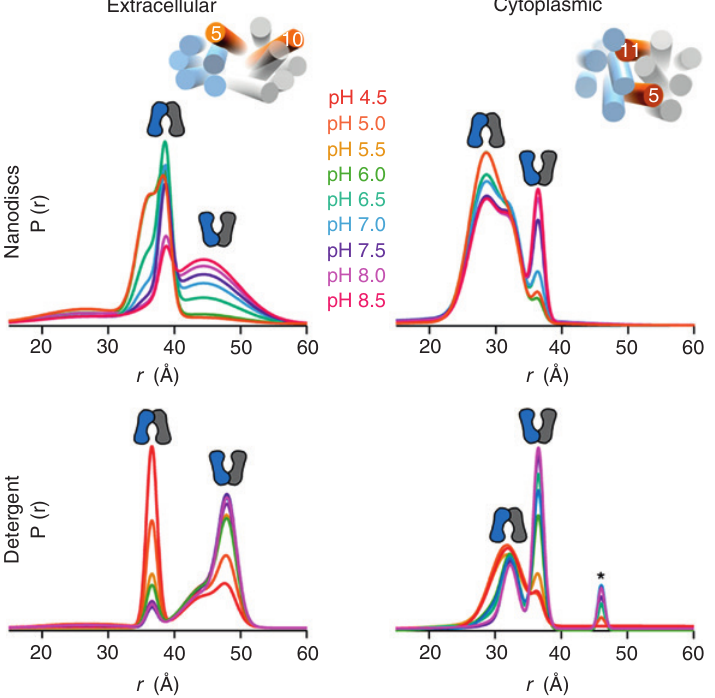
Figure 10: DEER distance distributions of the 160R1–310R1 and the 137R1–349R1 pairs, used as extracellular (left) and cytoplasmic (right) reporters, respectively, in the multidrug transporter LmrP. Top, mutants reconstituted in E. coli polar lipid nanodiscs, at pH values ranging from pH 5 to pH 8.5 in 0.5-unit increments. Bottom, mutants in detergent micelles, at pH values ranging from pH 4.5 to pH 8 in 0.5-unit increments. Asterisks denote peaks resulting from partial aggregation observed in some samples after concentration. Reprinted by permis- sion from Macmillan Publishers Ltd: [Nat Struct Mol Biol] (Martens C, Stein RA, Masureel M, Roth A, Mishra S, Dawaliby R, Konijnenberg A, Sobott F, Govaerts C, McHaourab HS. Nat. Struct. Mol. Biol . 2016, 23, 744–751), copyright (2016) and the kind agreement of Dr. Hassane Mchaourab. In this figure R1 denotes the cysteine residue with disulfide-linked